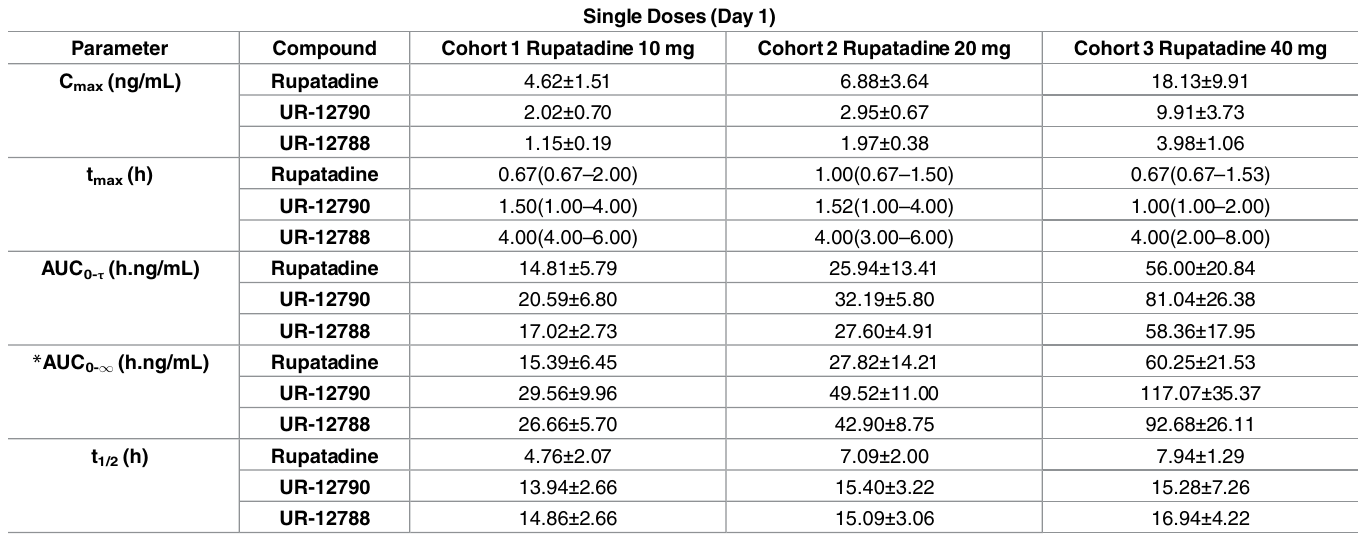
Table 2. Meanpharmacokinetic ( ± SD)parameters followingadministration of singledosesof rupatadine(10, 20 and 40 mg). Median(min–max)val- ues are presentedfor t max . Single Doses (Day